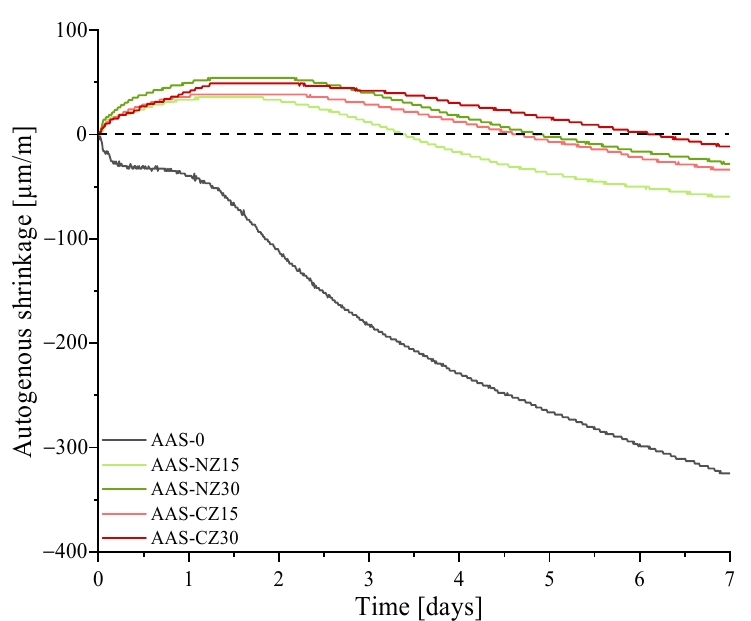
Figure 3. Autogenous shrinkage development curves of the alkali-activated slag (AAS) specimens from the final setting time to 7 days.